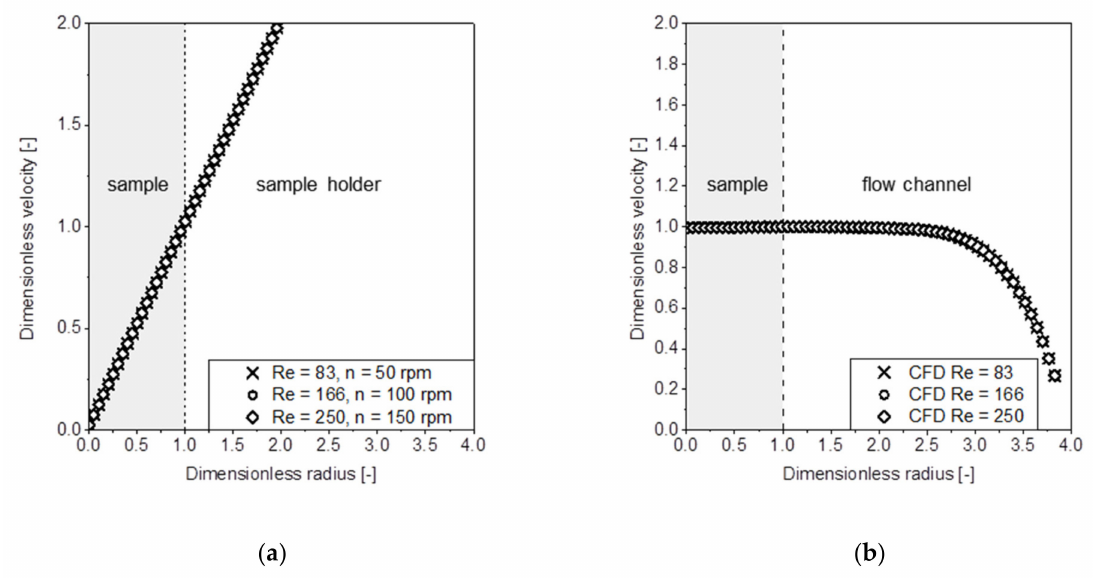
(cid:16) (cid:17) v i as a function of the v max